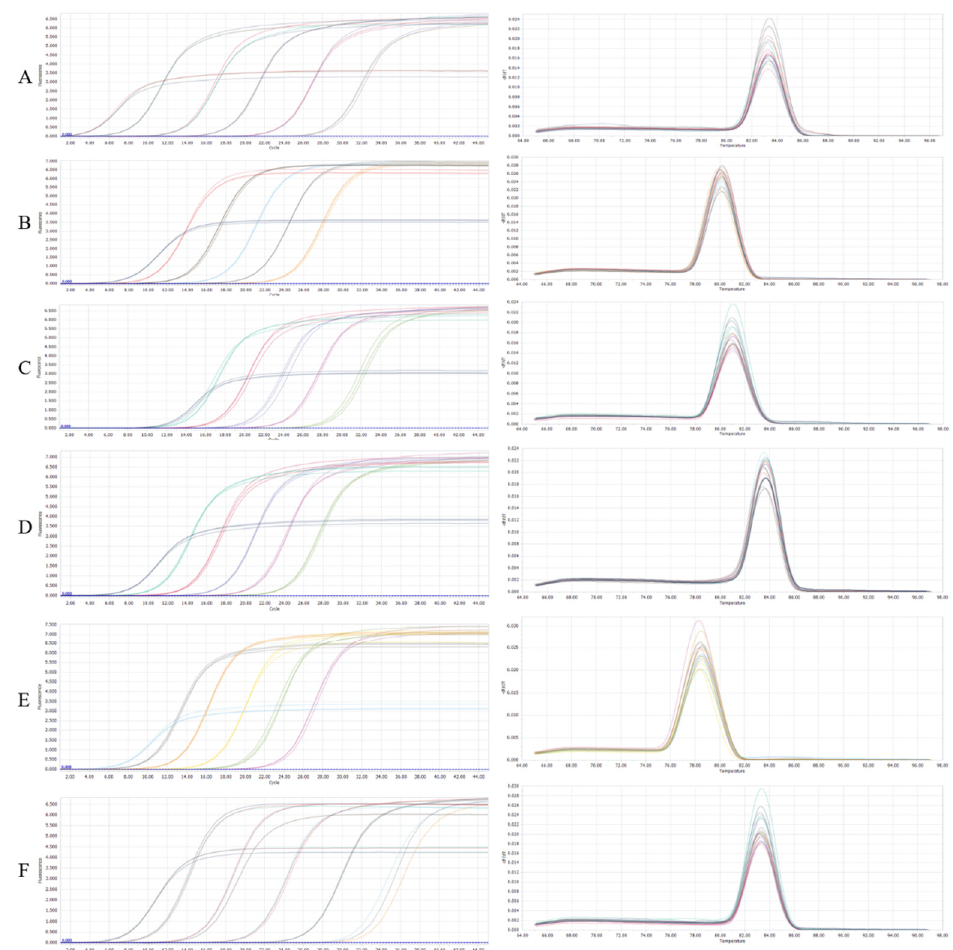
Figure 4. Amplification curve and dissolution curve. The left graph represents the amplification curve and the right graph is the lysis curve. ( A – F ) represented Lactobacillus acidophilus , Levilactobacillus brevis , Lactobacillus delbrueckii subsp. bulgaricus , Limosilactobacillus fermentum , Streptococcus thermophilus , and Lacticaseibacillus casei , respectively.